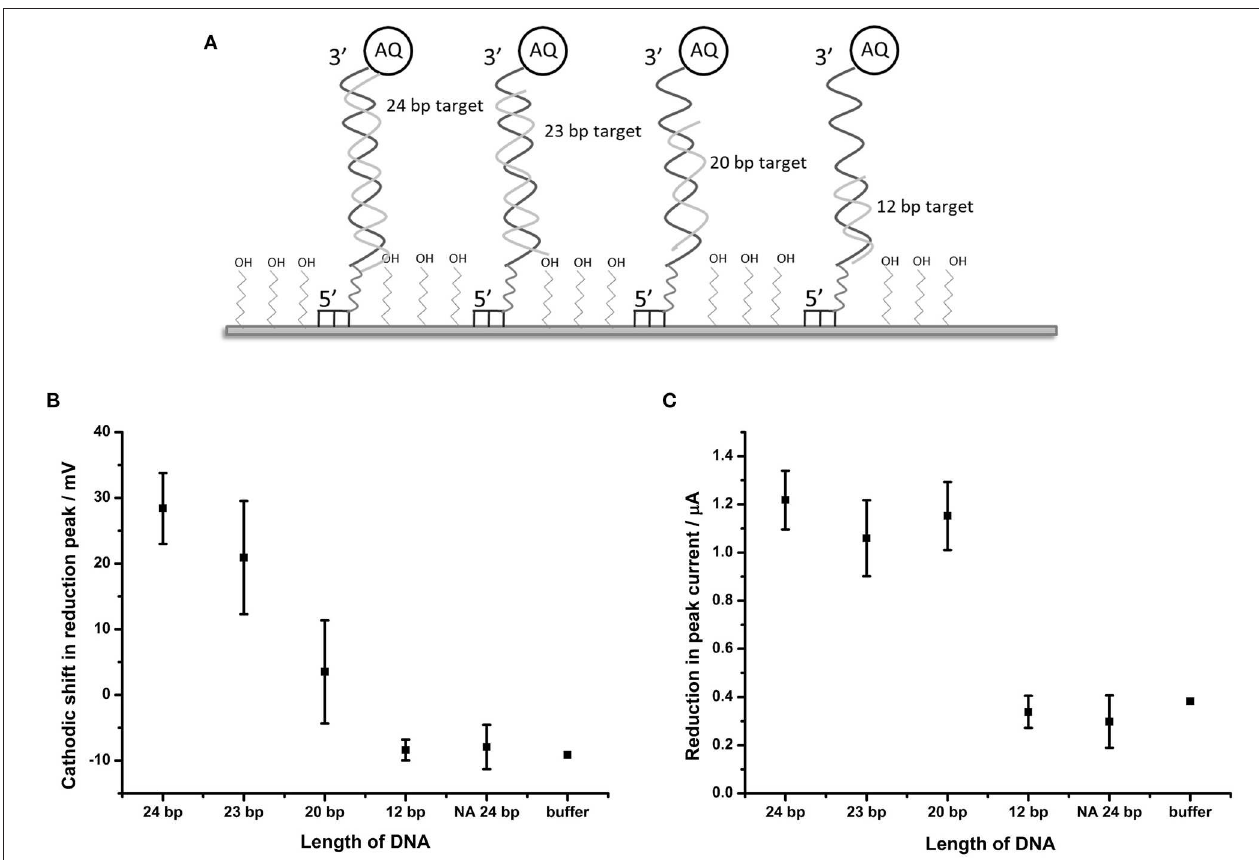
FIGURE 5 | Distance dependent effects of binding complementary DNA to probe BA-1. (A) Schematic description of the experimental design showing the position of binding of the shortened DNA strands in relation to the AQ tag. (B) Plot showing shift in the potential of the reduction peak and (C) plot of the change in peak current in response to hybridization of complementary DNA of different lengths. Points represent an average of the responses shown by three replicate electrodes (error bars indicate 95% confidence